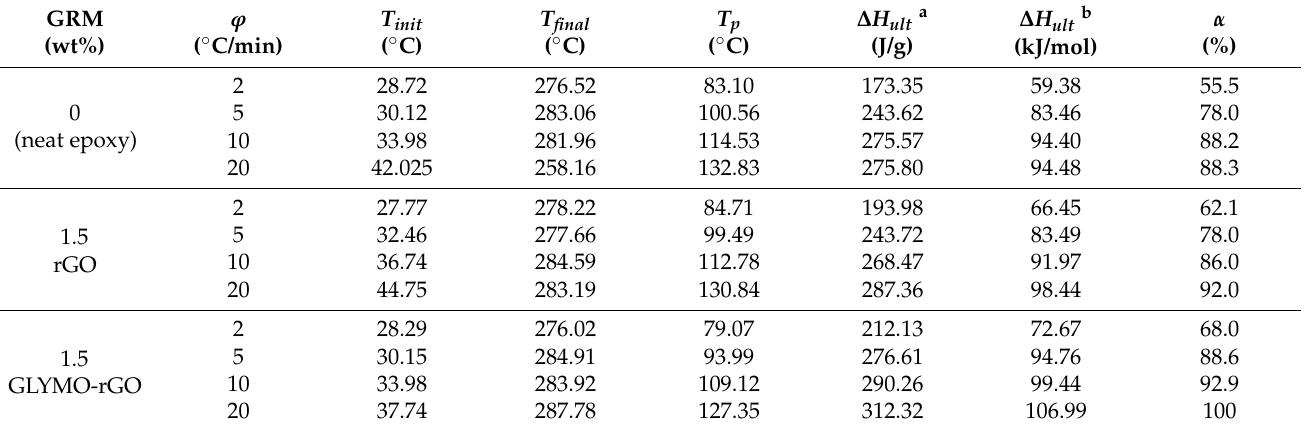
a . ∆ H ult (J/g) refers to 1 gr mixture of epoxy determined from the experimental value divided by 0.540. (kJ/mol) calculated from ∆ H ult (kJ/g) × 185 (=EEW of Epilok 60-600G).